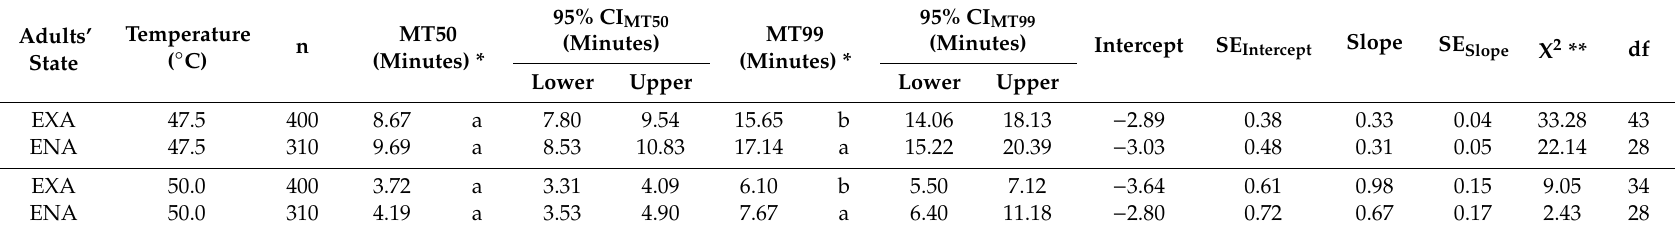
Table 2. Time causing mortality (MT) 50 and 99 with 95% confidence interval (CI) for Halyomorpha halys adults exposed to high temperatures, with probit regression